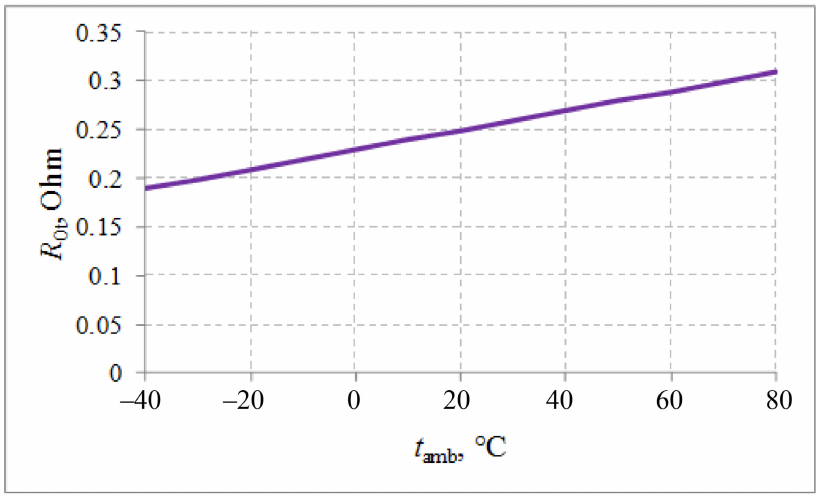
Figure 5. Relationship between the resistance of the AC-120 wire with a length of 1 km and the ambient